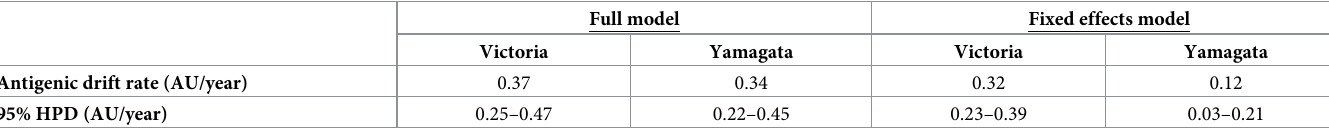
Table 2. Estimated antigenic drift rate for influenza B virus Victoria and Yamagata lineages inferred using